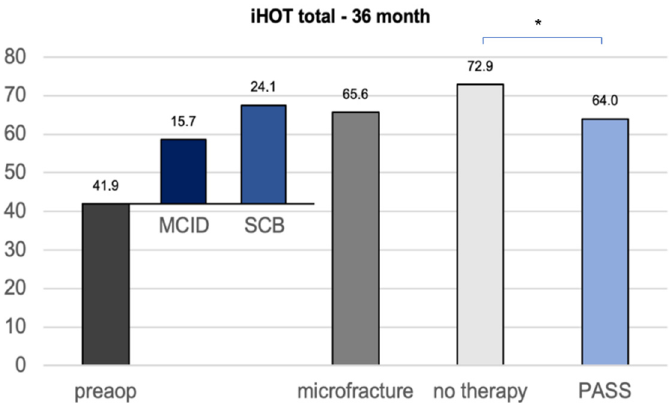
Figure 3. CIOVs of the iHOT33 36 months after hip arthroscopy with or without microfracture of the apparent cartilage defects. MCID minimum clinically important difference SCB substantial clinical benefit (change) PASS patient acceptable symptom state. Significant differences (* p < 0.05) are designated by asterisks.